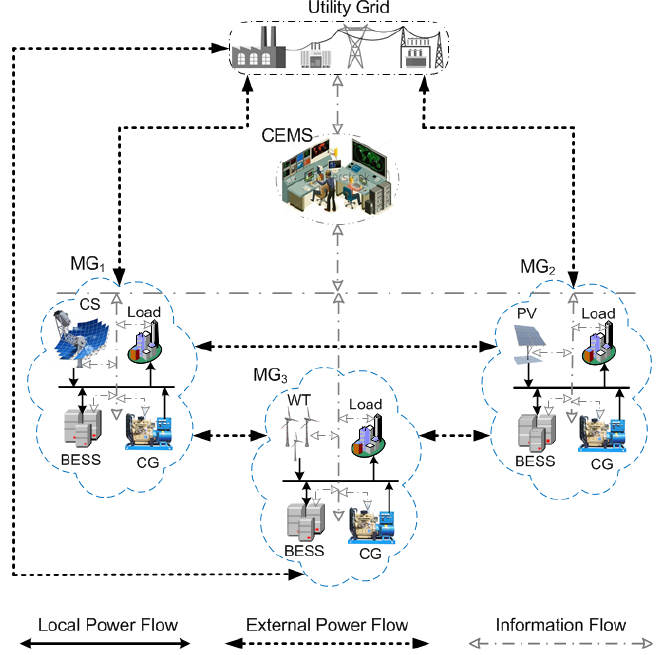
Figure 3. An illustration of a typical multi-microgrid system.